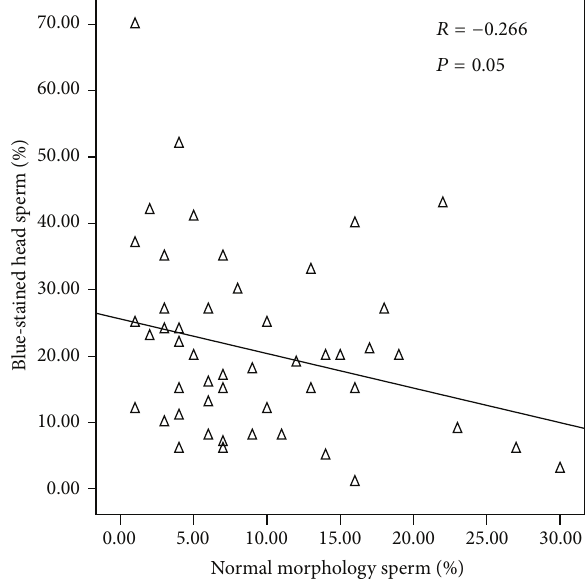
Figure 2: Correlation between sperm nucleus maturity and sperm